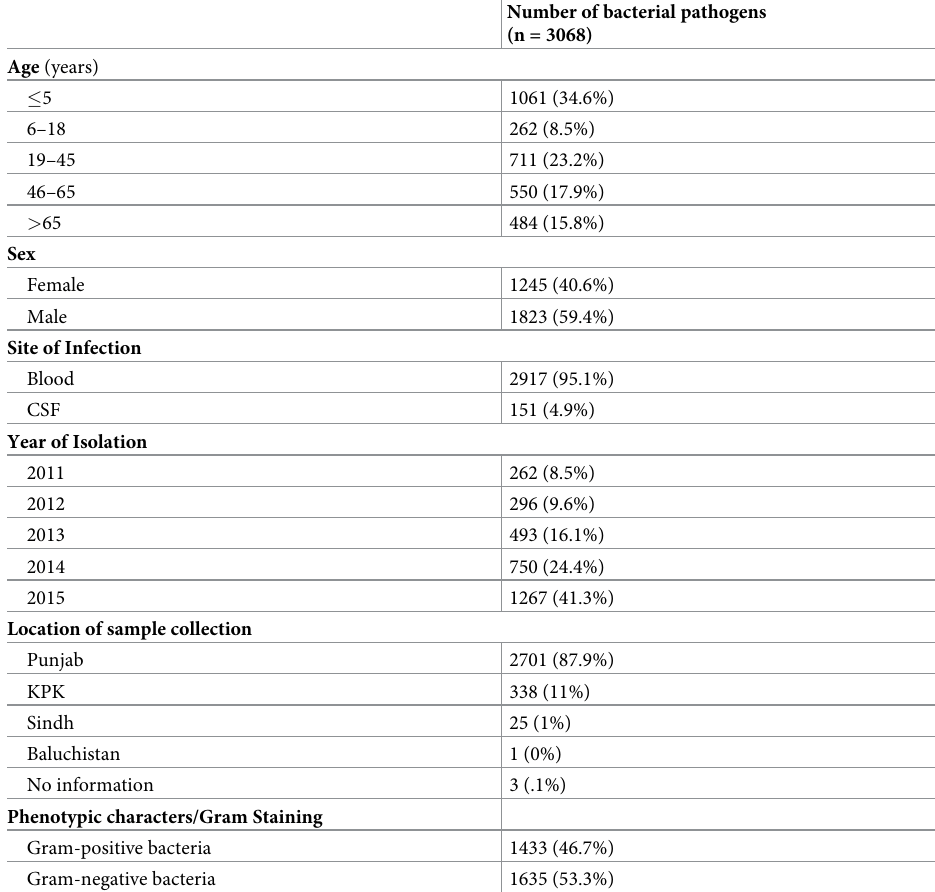
Table 1. Attributes of pathogens isolated from blood and cerebrospinal fluid between 2011–2015 in